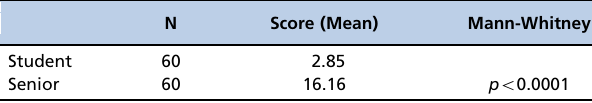
Table 1 - Comparison of the distribution of final scores obtained within the sample of students and senior